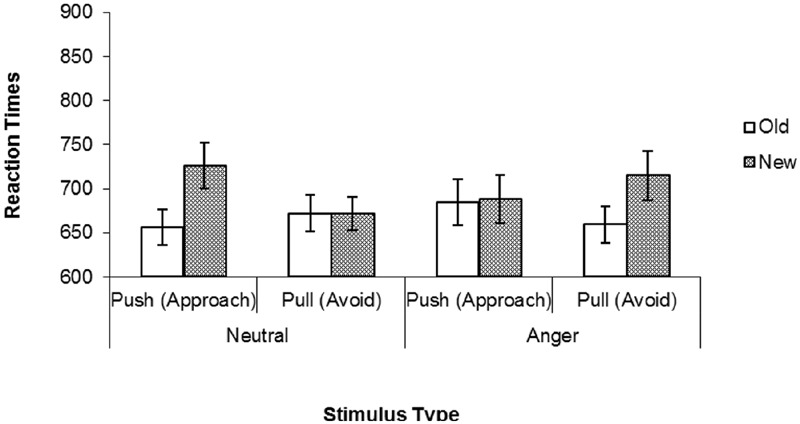
Reaction times to perform pushing and pulling motions in response to familiar (Old) and novel (New) targets for each stimulus type in Experiment 2.